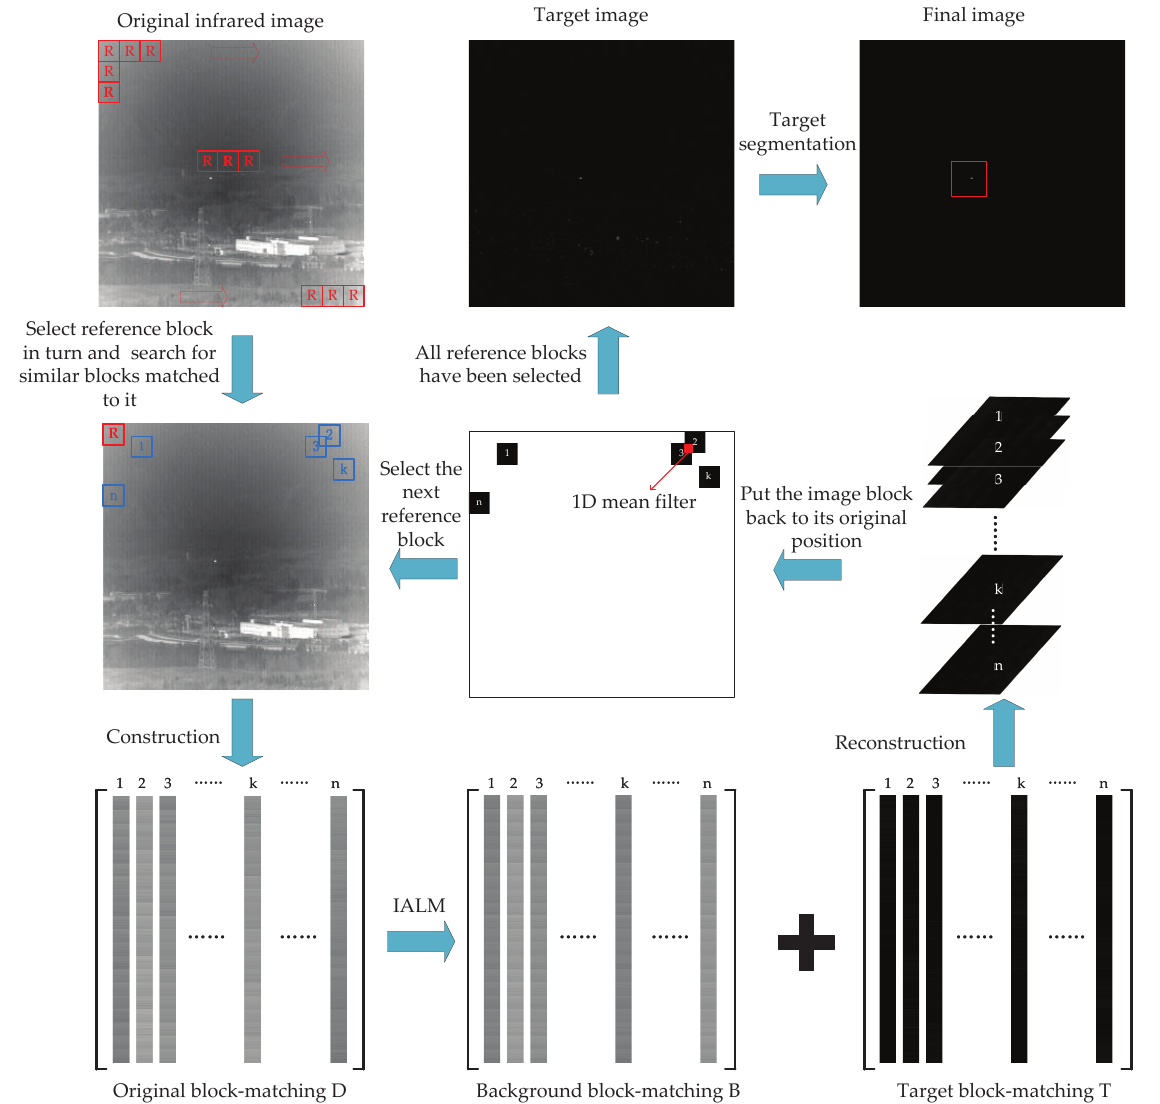
Figure 3. The overview of the proposed method in this